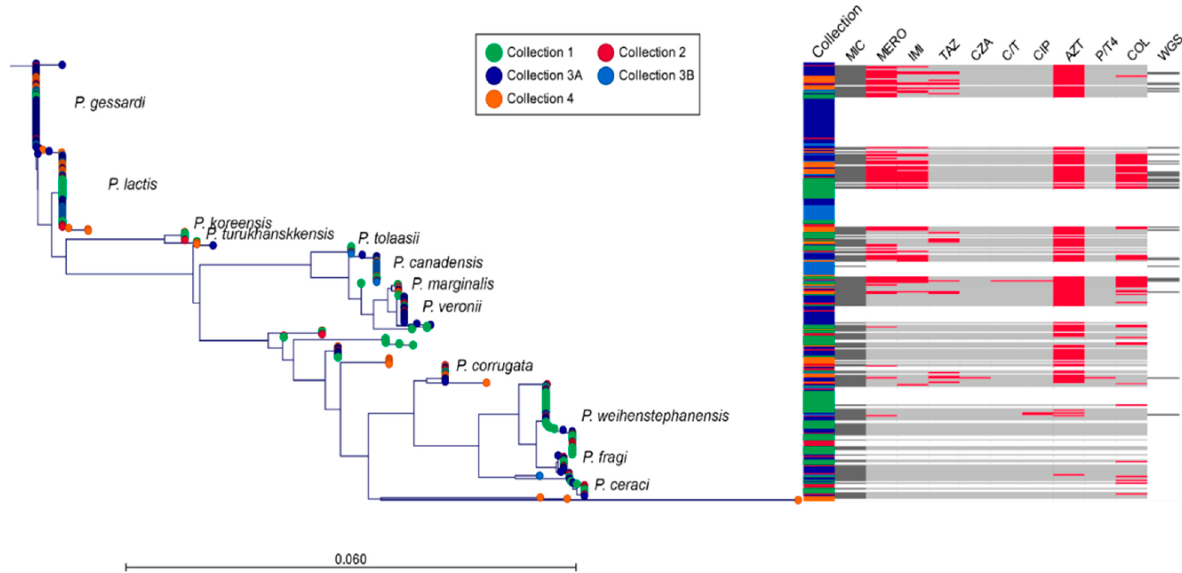
Figure 1. Phylogenetic distribution of Pseudomonas spp. isolates (n = 325) based on partial 16S rRNA gene (288 bp) sequencing. Assignment of the isolates to presumptive species and to the strain collections is indicated. The subsets of isolates subjected to MIC (n = 175) and WGS (n = 31) analyses are shown. Isolates with resistance to the specific antibiotics are indicated in red. Antibiotic abbreviations: MERO (meropenem), IMI (imipenem), TAZ (ceftazidime), CZA (ceftazidime/avibactam), C/T (ceftolozane/tazobactam), CIP (ciprofloxacin), AZT (aztreonam), P/T4 (piperacillin/tazobactam), COL (colistin). Antibiotics for which all isolates were sensitive (amikacin, gentamicin, tobramycin; according to Table 2) were not included. Table 2. Minimum inhibitory concentrations (MIC) and antimicrobial resistance in Pseudomonas spp. (n = 175) isolated from raw chicken in Norway.